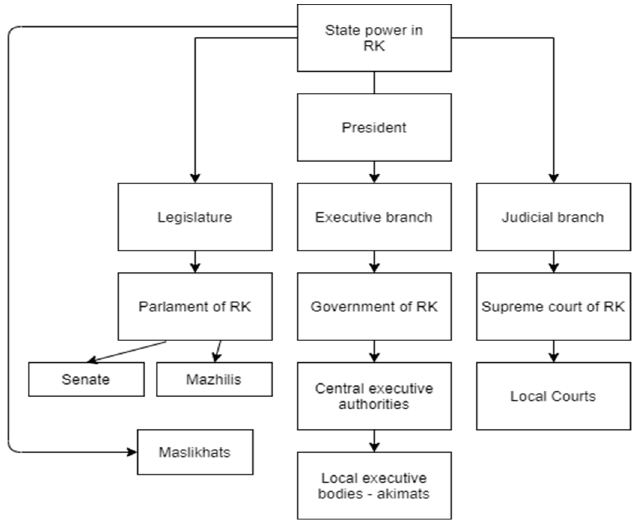
Figure 2. State power hierarchy of RK.